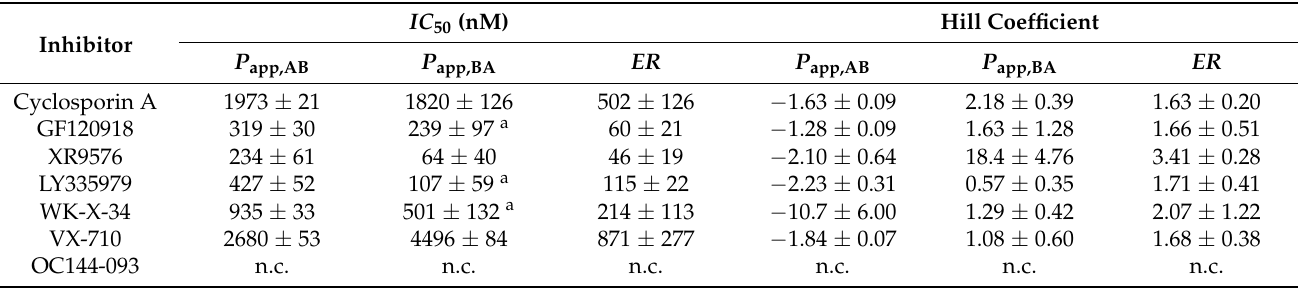
Table 1. Fifty percent inhibitory concentration ( IC 50 ) values and Hill coefficient of selected inhibitors on apparent AP-to-BL and BL-to-AP permeability, and efflux ratio ( ER ) of paclitaxel in Caco-2 cell monolayers.